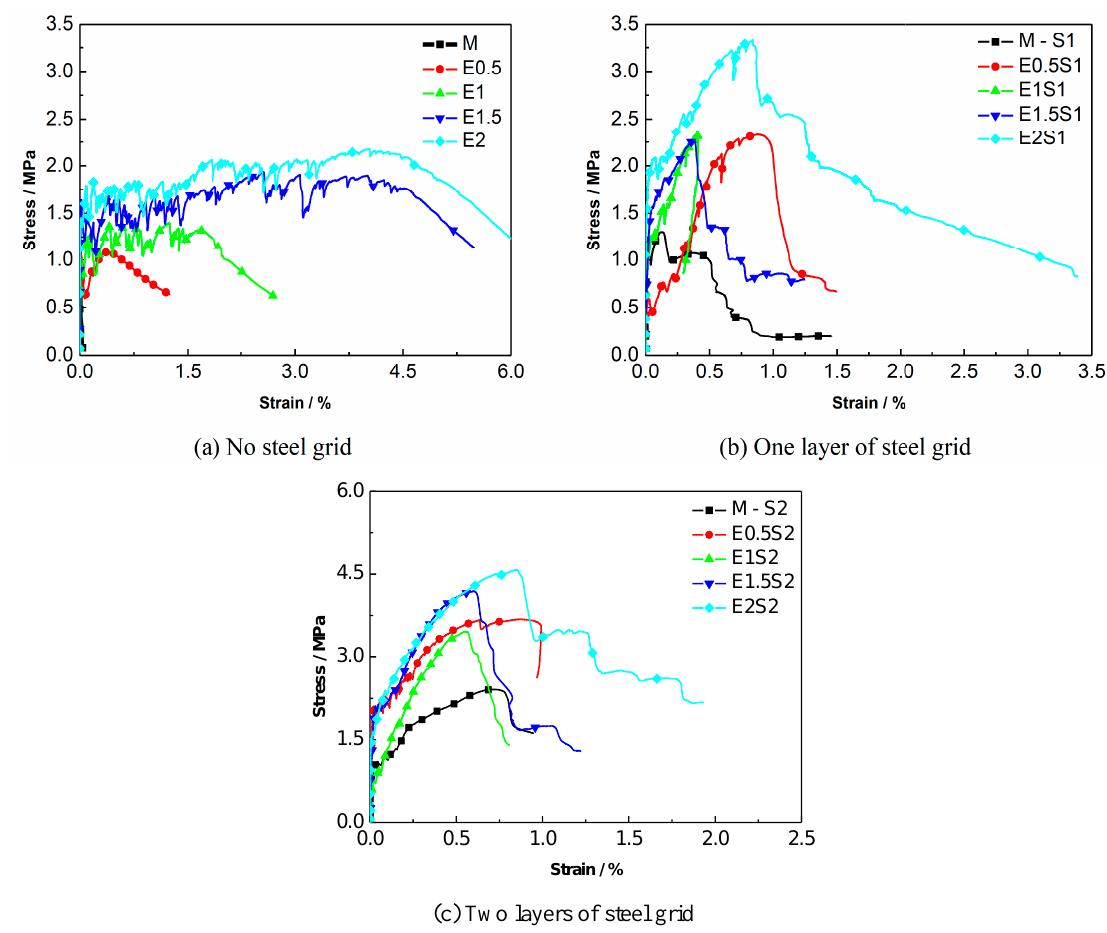
Fig.13 Comparison of stress-strain curves of ECC specimens with different PE fiber volume fractions Figure 13. Comparison of stress-strain curves of ECC specimens with di ff erent PE fiber volume fractions. ( a ) No steel grid; ( b ) One layer of steel grid; ( c ) Two layers of steel